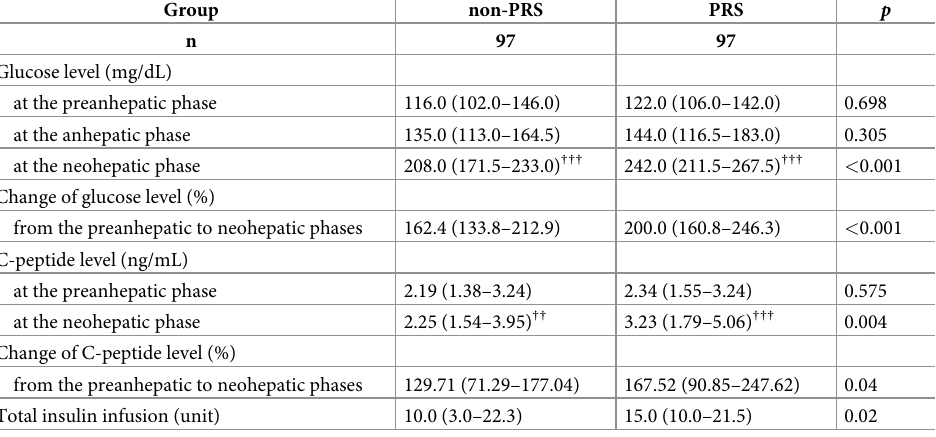
Table 2. Comparison of intraoperative glucose and C-peptide levels and requirement of insulin infusion in PS- matched patients with/without PRS.